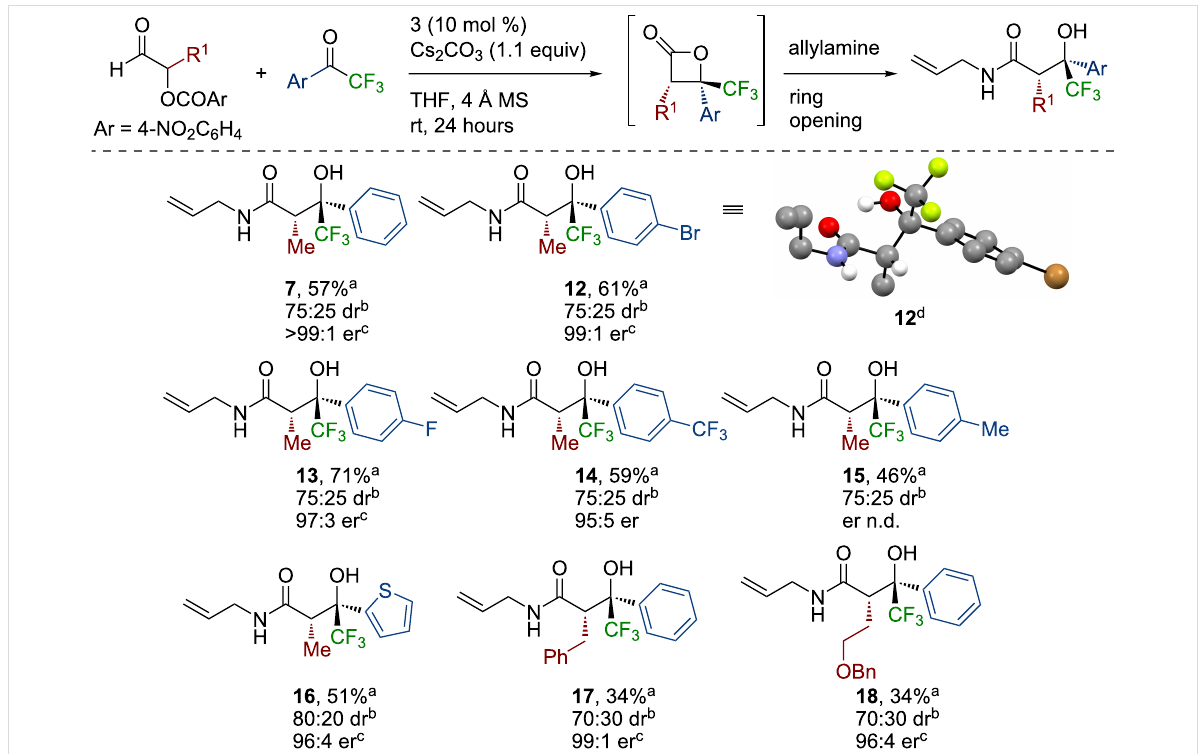
Scheme 2: Reaction scope with respect to the trifluoroacetophenone derivative and α -aroyloxyaldehyde. a Isolated yield of the product in >95:5 dr. b Determined by 1 H NMR spectroscopic analysis of the crude reaction product mixture. c er of the major diastereoisomer (>95:5 dr), determined